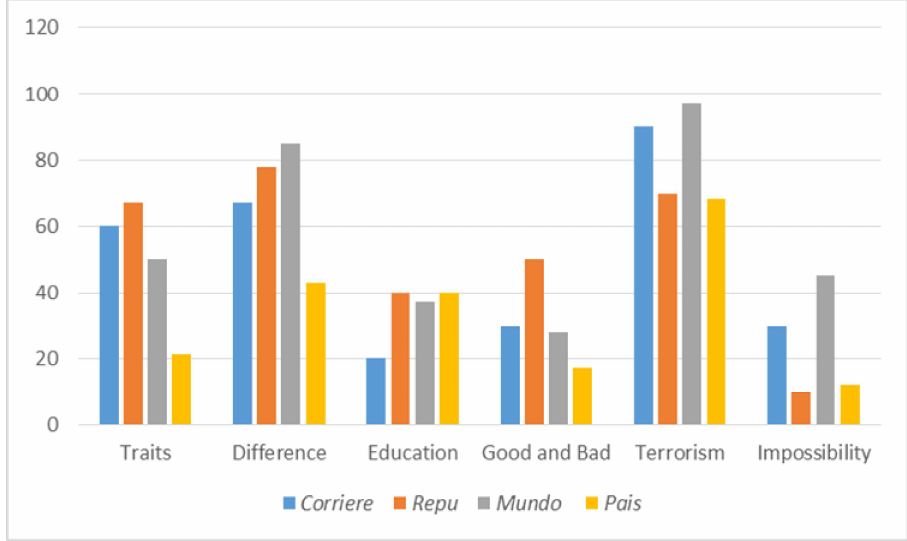
Figure 6. Categories of Islamophobic message. Source: elaborated by the authors.